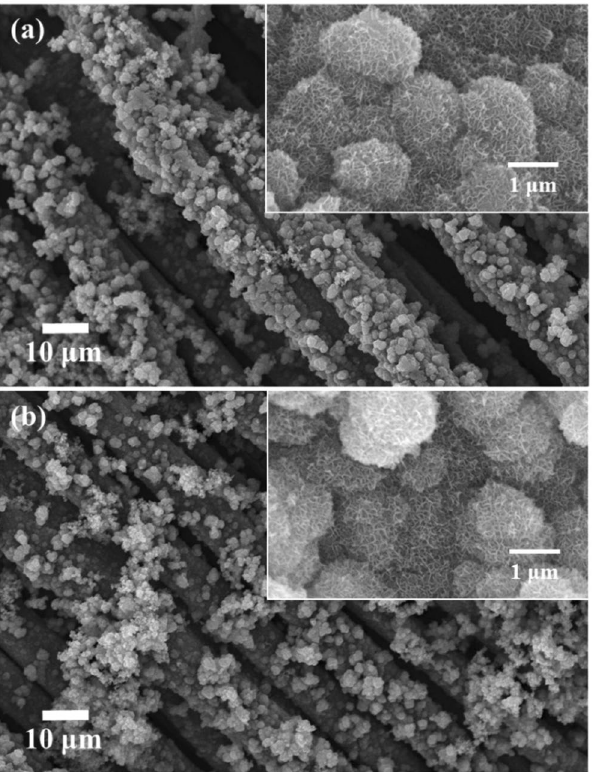
Figure 1. SEM micrograph of hydrothermally synthesized MnO 2 in ( a ) un-annealed and ( b ) annealed